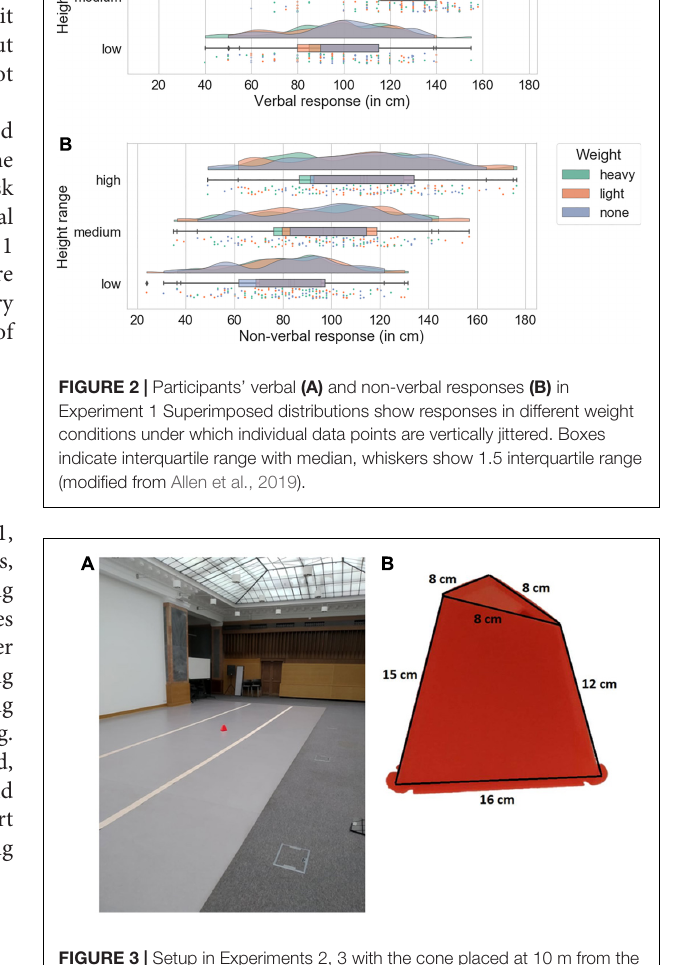
FIGURE 3 | Setup in Experiments 2, 3 with the cone placed at 10 m from the participant (A) . Dimensions of the target cone. Dimensions of the target cone (B)